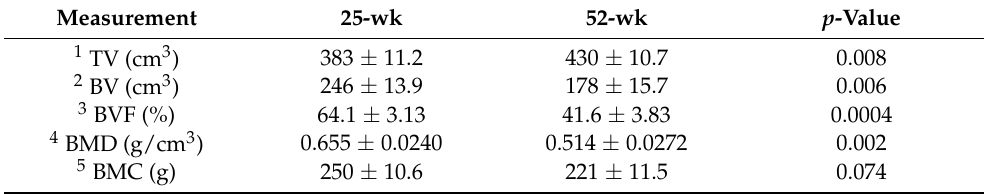
Table 5. Morphology, based on micro-CT scanning, of tibial diaphysis from Hy-Line W36 hens.